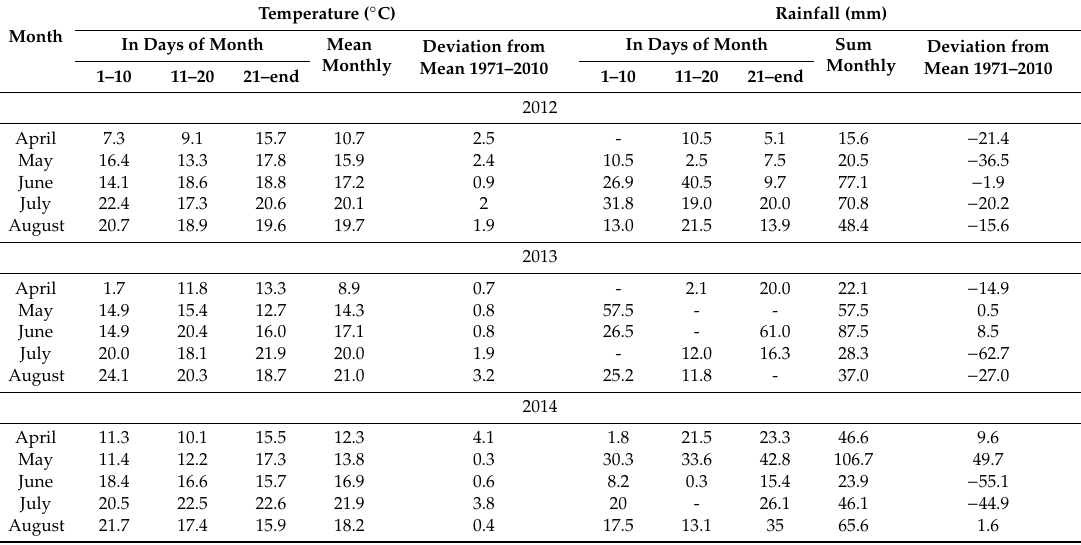
Table 2. Mean air temperature and sum of rainfall during the growing period of tomato in 2012–2014. Temperature ( ◦ C) Month